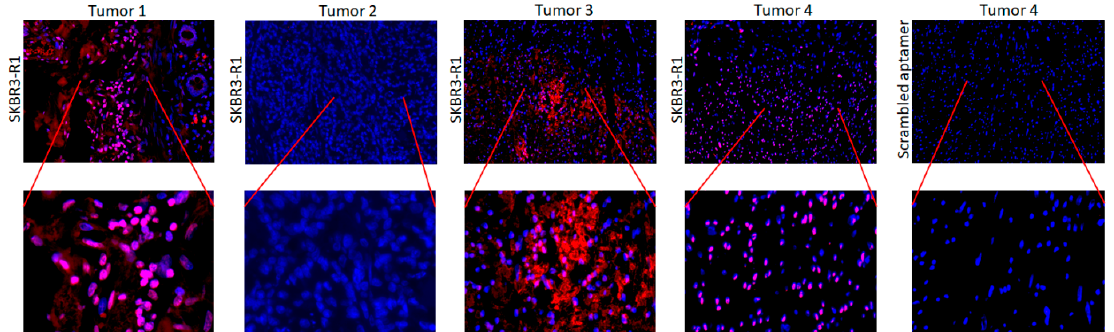
Figure 10. Fluorescent images of 4 FFPE breast cancer tissue sections stained with SKBR3-R1-AF594 or Scrambled-AF594 aptamer.